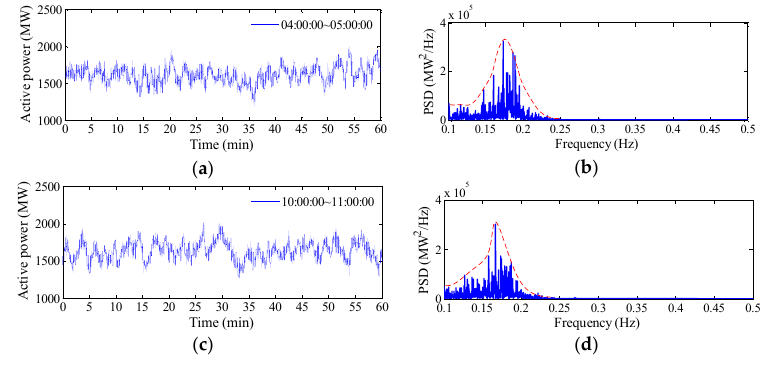
Figure 2. Cont . Figure 2. Cont